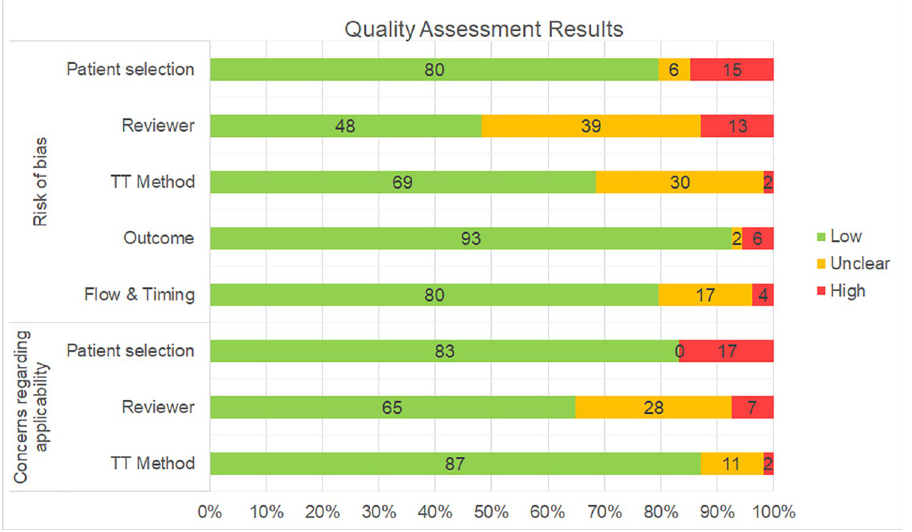
Fig 2. Quality assessment of all included studies. Assessments are presented in risk of bias and applicability-related concerns . (TT method, Trigger Tool